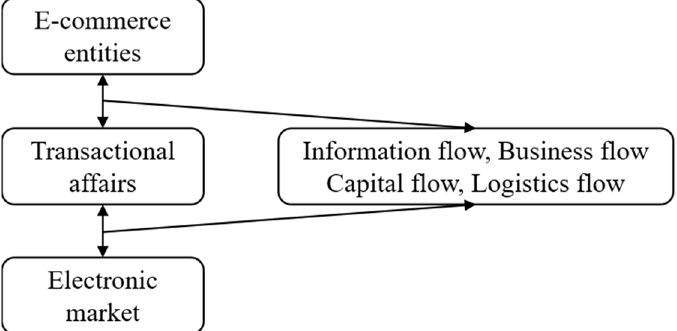
Figure 4. Blockchain-based IoT model and conceptual model of an urban logistics system.